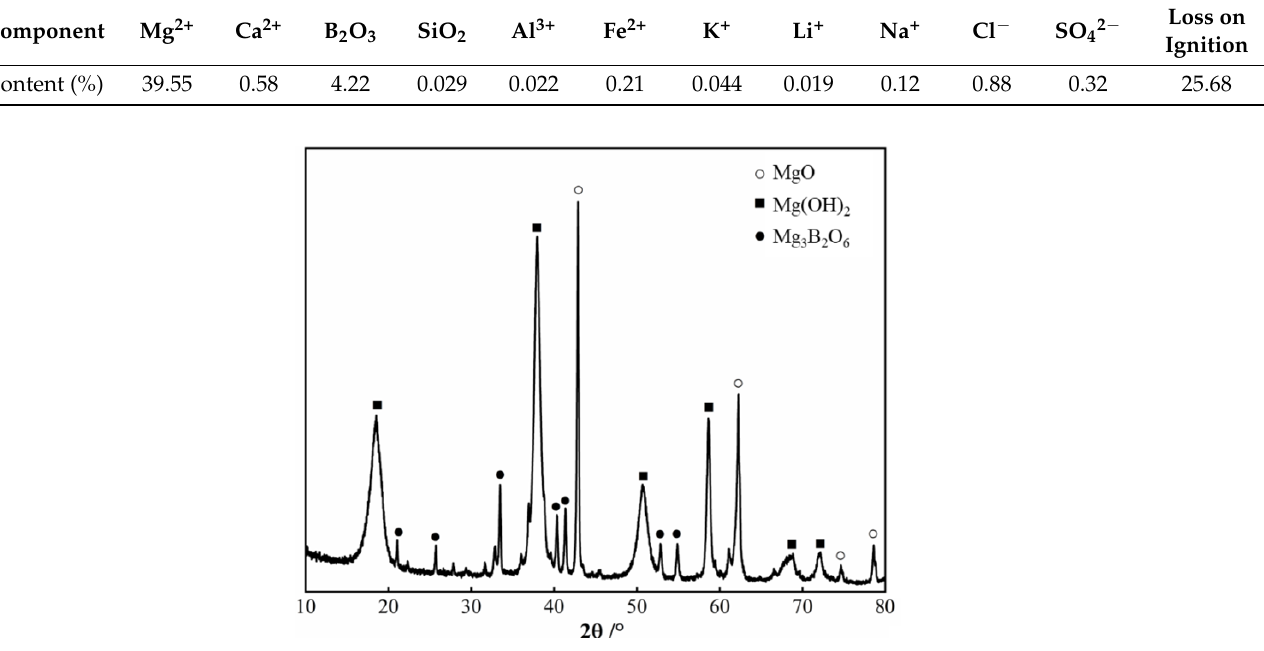
Figure 1. XRD spectrum of MR.